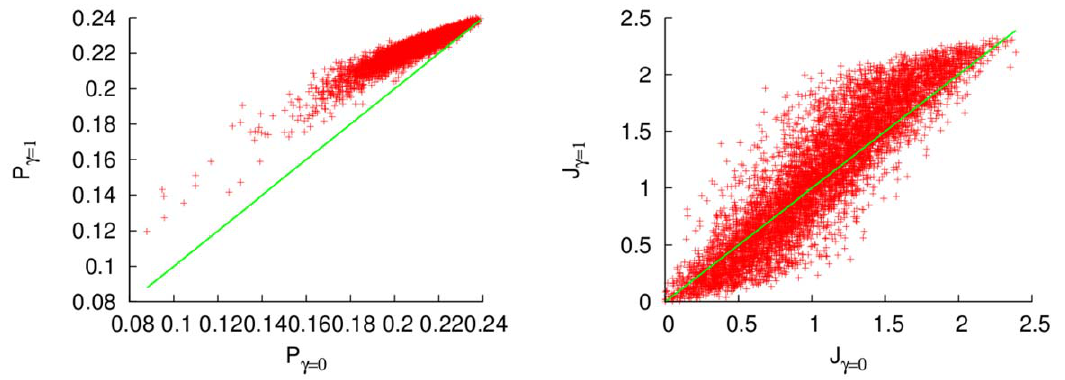
Figure 3. Excitation (left) and energy (right) fluxes for random Hamiltonians in the low-temperature regime ( n ~ 1 ), for a dephasing ratio c ~ 1 as a function of the fluxes without dephasing. The green line separates the configurations with enhancement and depression of the transfer. Units of cm { 1 .